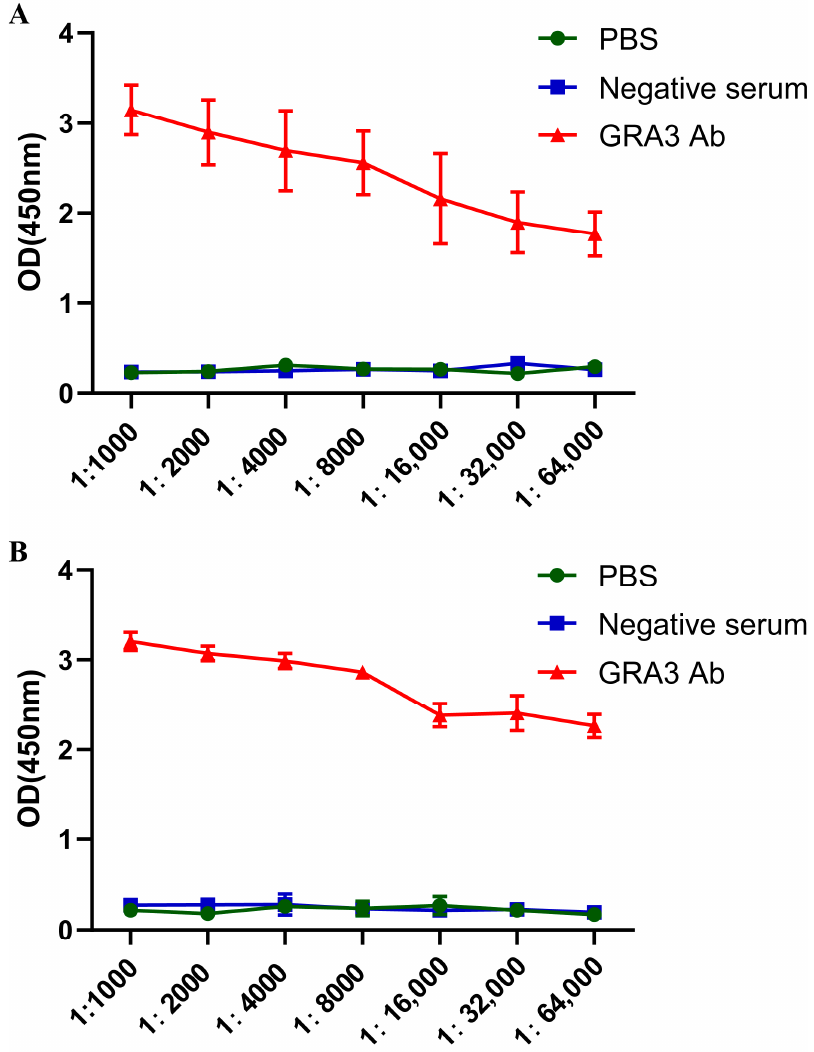
Figure 3 . Determination of antibody potency. ( A ) The whole protein solution after denaturation of inclusion bodies were diluted to 5 μ g/mL with the coating solution. The potency of antibodies in immunized rabbit sera was measured by indirect ELISA, and the dilution ratio of antibodies was adjusted to 1:64,000. Sera from normal rabbits and PBS were used as negative controls. ( B ) The three peptides of GRA3 were diluted to 5 μ g/mL with the coating solution. The potency of the antibody in the immunized rabbit serum was detected by indirect ELISA at a dilution of 1:64,000. The serum of normal rabbit and PBS acted as negative control. The final result was consistent with group A.